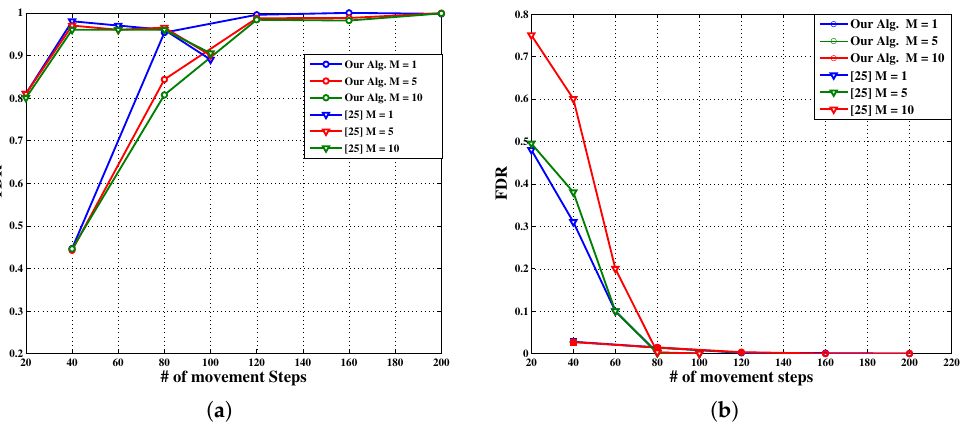
Figure 14. Performance comparison of [25] and our new proposed method in terms of TDR ( a ) and FDR ( b ) versus number of movement steps for varying number of malicious